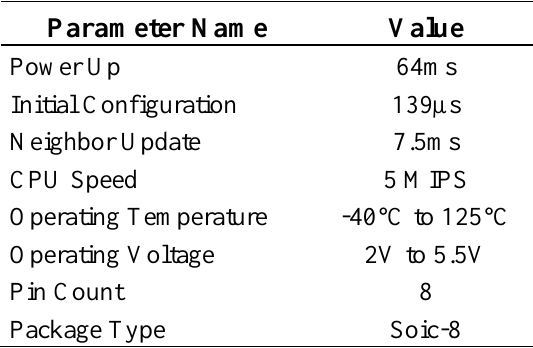
Table 2. Specifications of the router